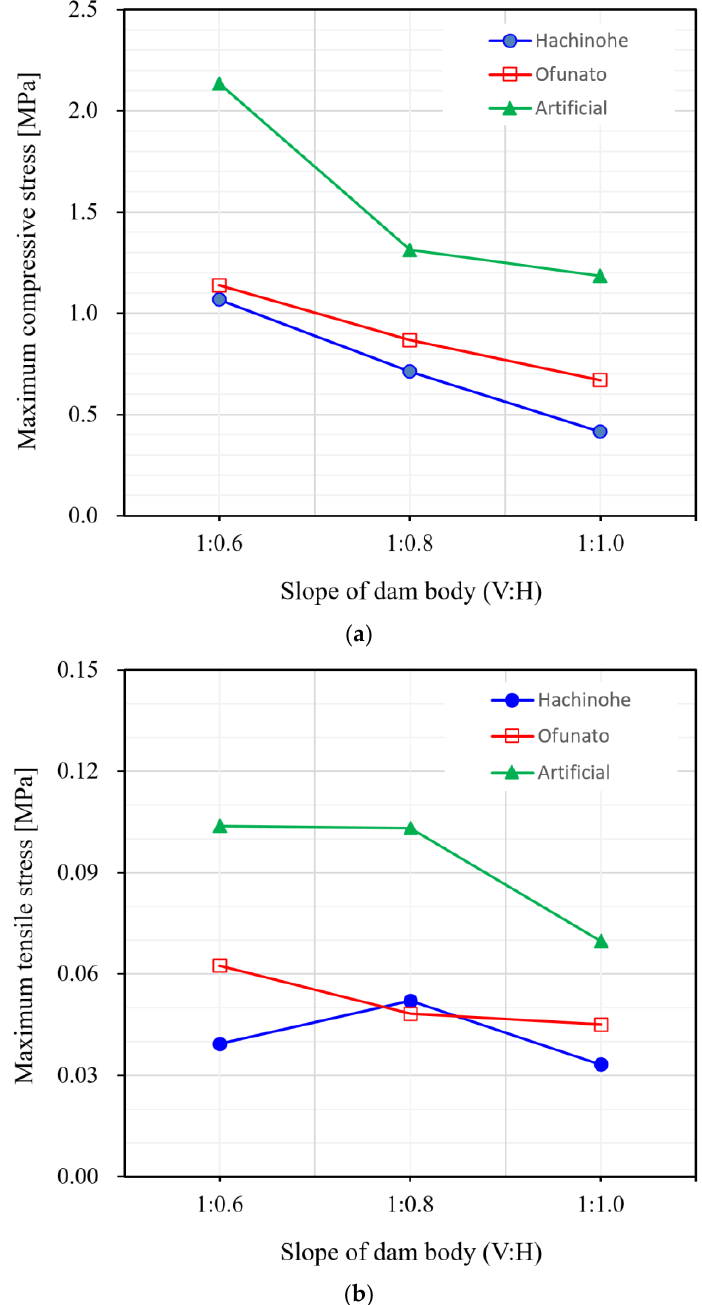
Figure 13. Results of FE analysis (maximum compressive and tensile stresses). ( a ) Maximum compressive stress. ( b ) Maximum tensile stress.